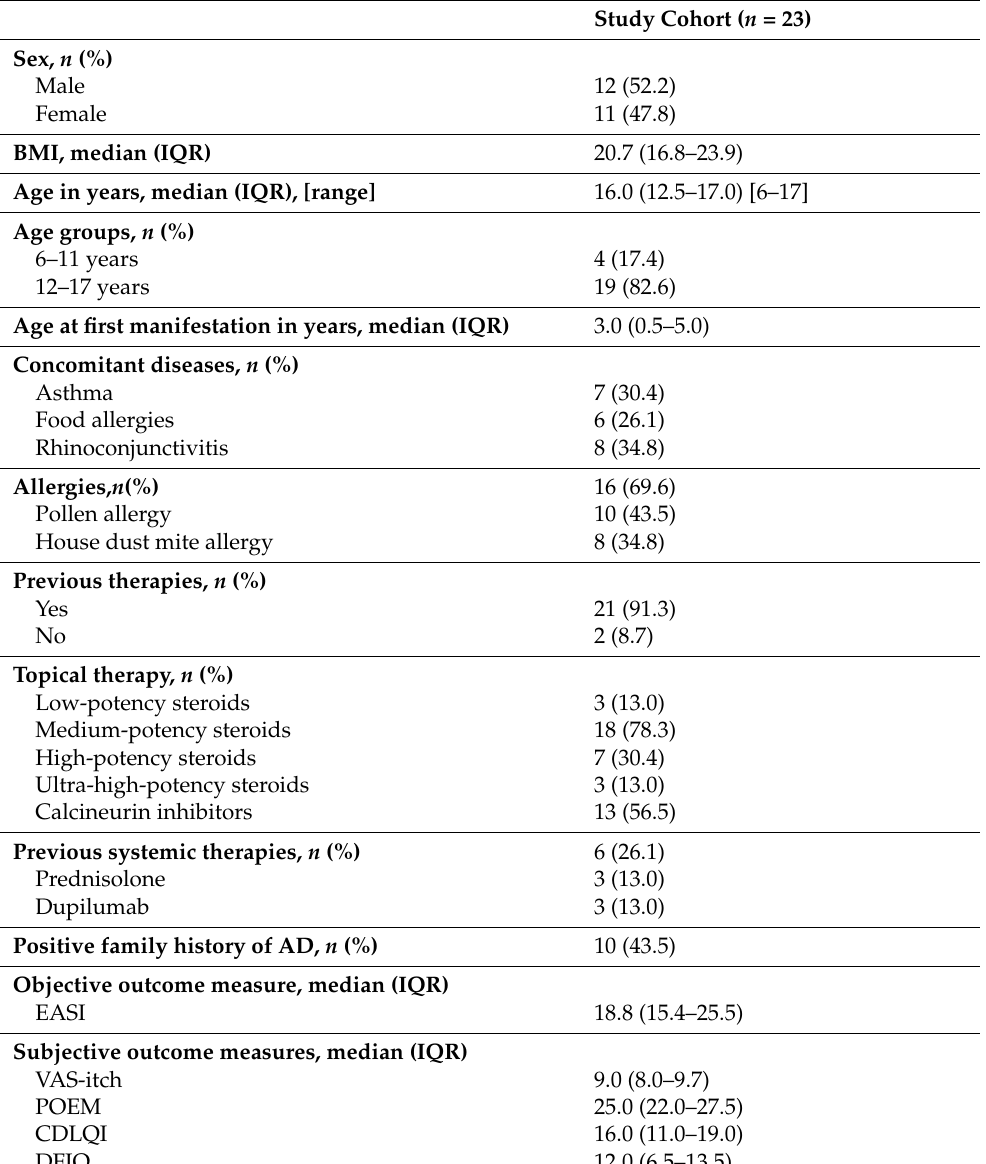
Table 1. Baseline demographics and clinical